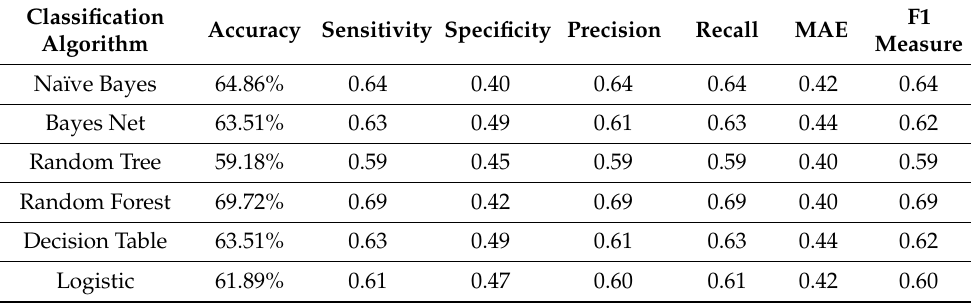
Table 8. HOG results on Dataset-I.